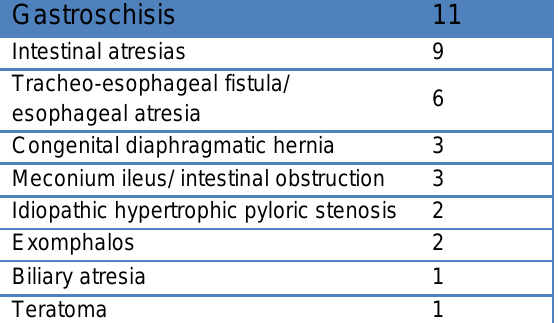
Table 1: Surgical